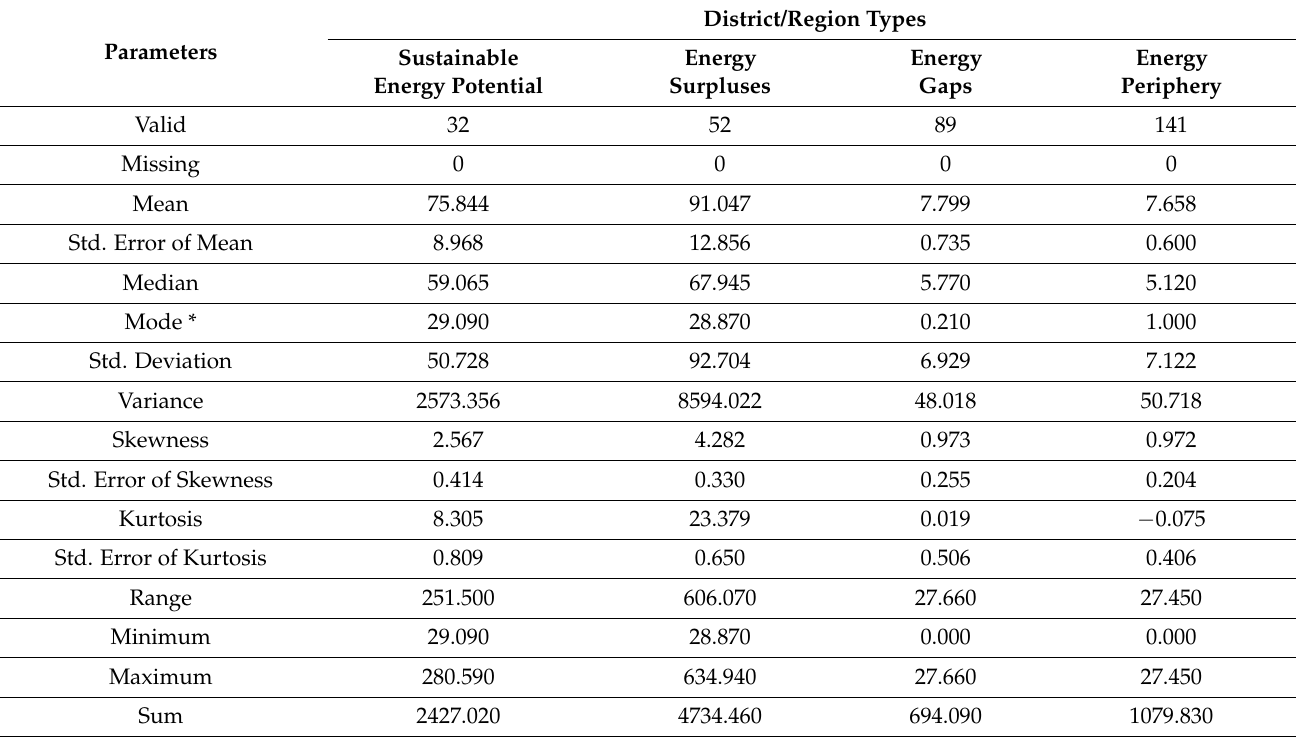
Figure 8. Spatial distribution of districts according to outlined types in 2020. Source: own calculations and presentation. Table 3. Descriptive statistics for the analysis of districts according to their renewable energy generation